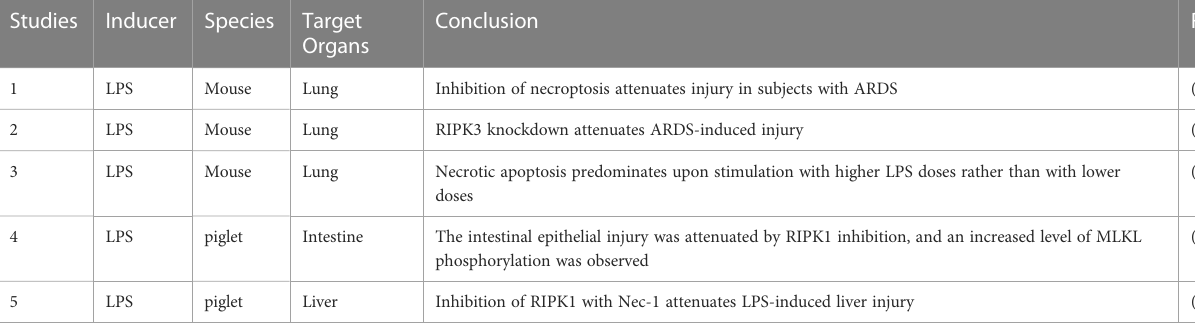
TABLE 3 Study on RIPK1 and downstream sites in sepsis model. Studies Inducer Species Target